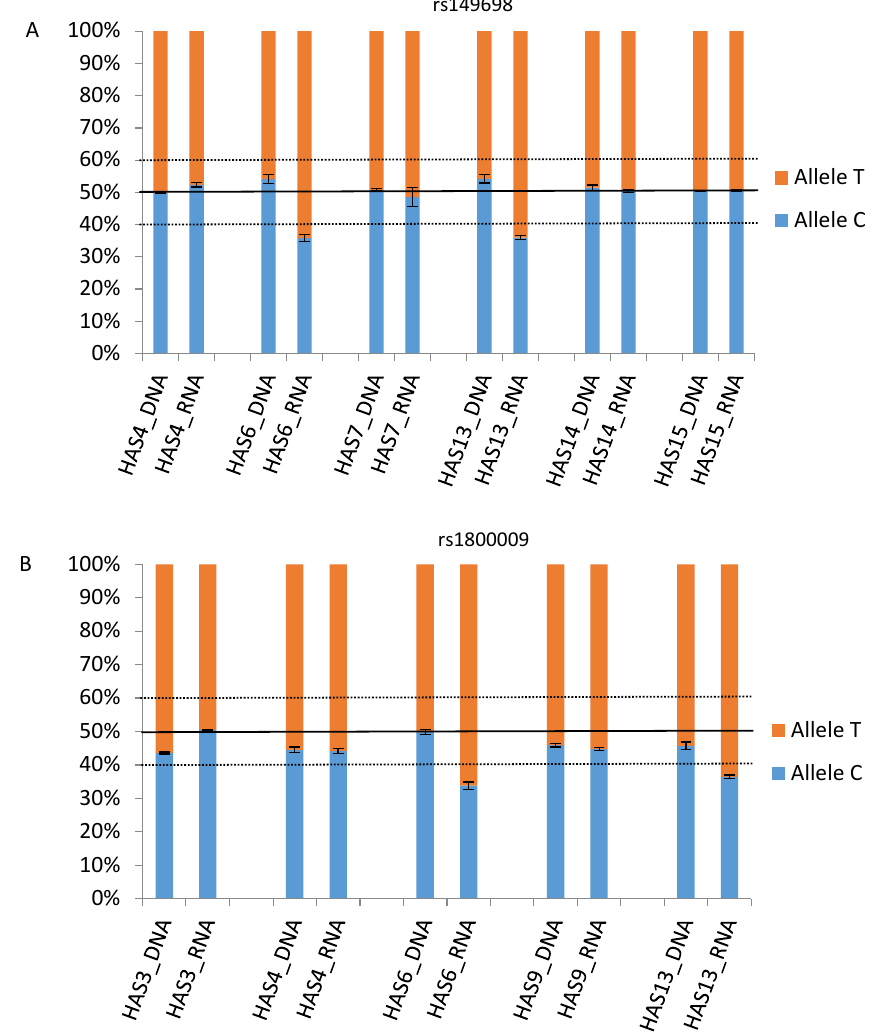
Figure 3. Relative allele percentages for SNPs rs149698 and rs1800009in BEST1 at the DNA and RNA levels. Allelic balance is delimited within the 40–60% range. Error bars correspond to the standard of the mean (SEM) of allele A. ( A ) BEST1 rs149698 pyrosequencing results. Allele percentages at the DNA level remained close to 50%. At the RNA level, there was a bias in HAS6 and HAS13 in favor of allele T. ( B ) BEST1 rs1800009 pyrosequencing results. Similar to rs149698, the DNA levels remained balanced, whereas at the RNA level again HAS6 and HAS13 allele T were overrepresented.